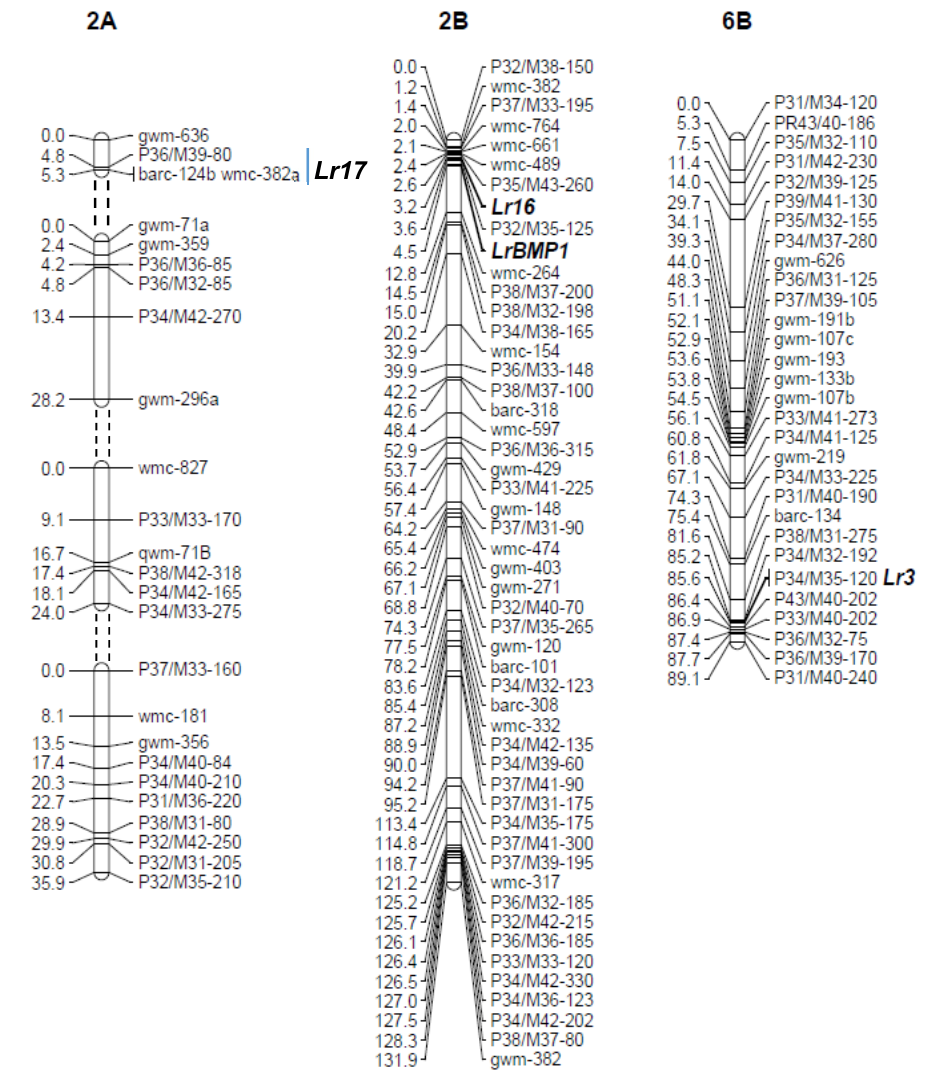
Figure 2. Linkage group of chromosomes 2A, 2B and 6B. On the left, cumulative genetic distances in cM. On the right, leaf rust resistance genes are shown in bold together with molecular markers.